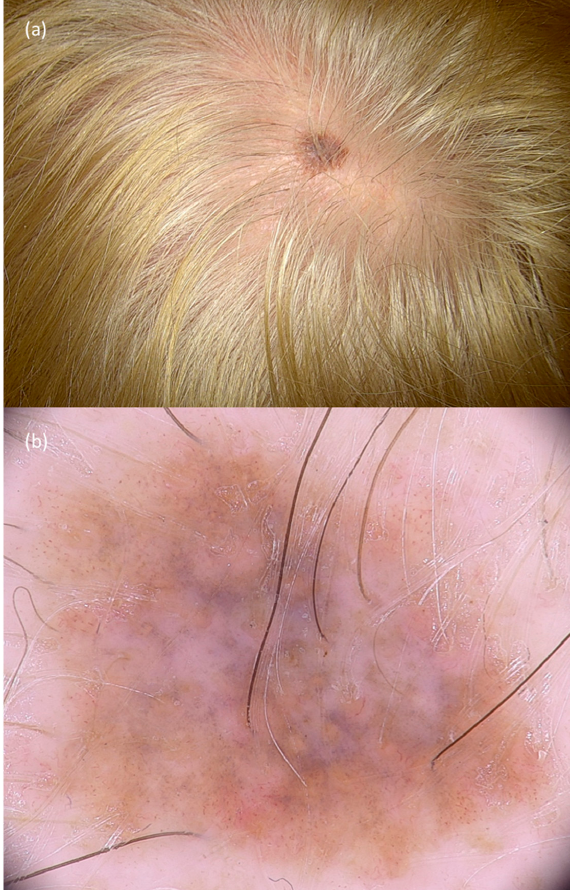
Figure 4. Scalp melanoma: clinical presentation ( a ) showing a brownish-to-bluish macule. Dermoscopy ( b ) revealed an irregular brown pseudo-network with a central blue veil and regression